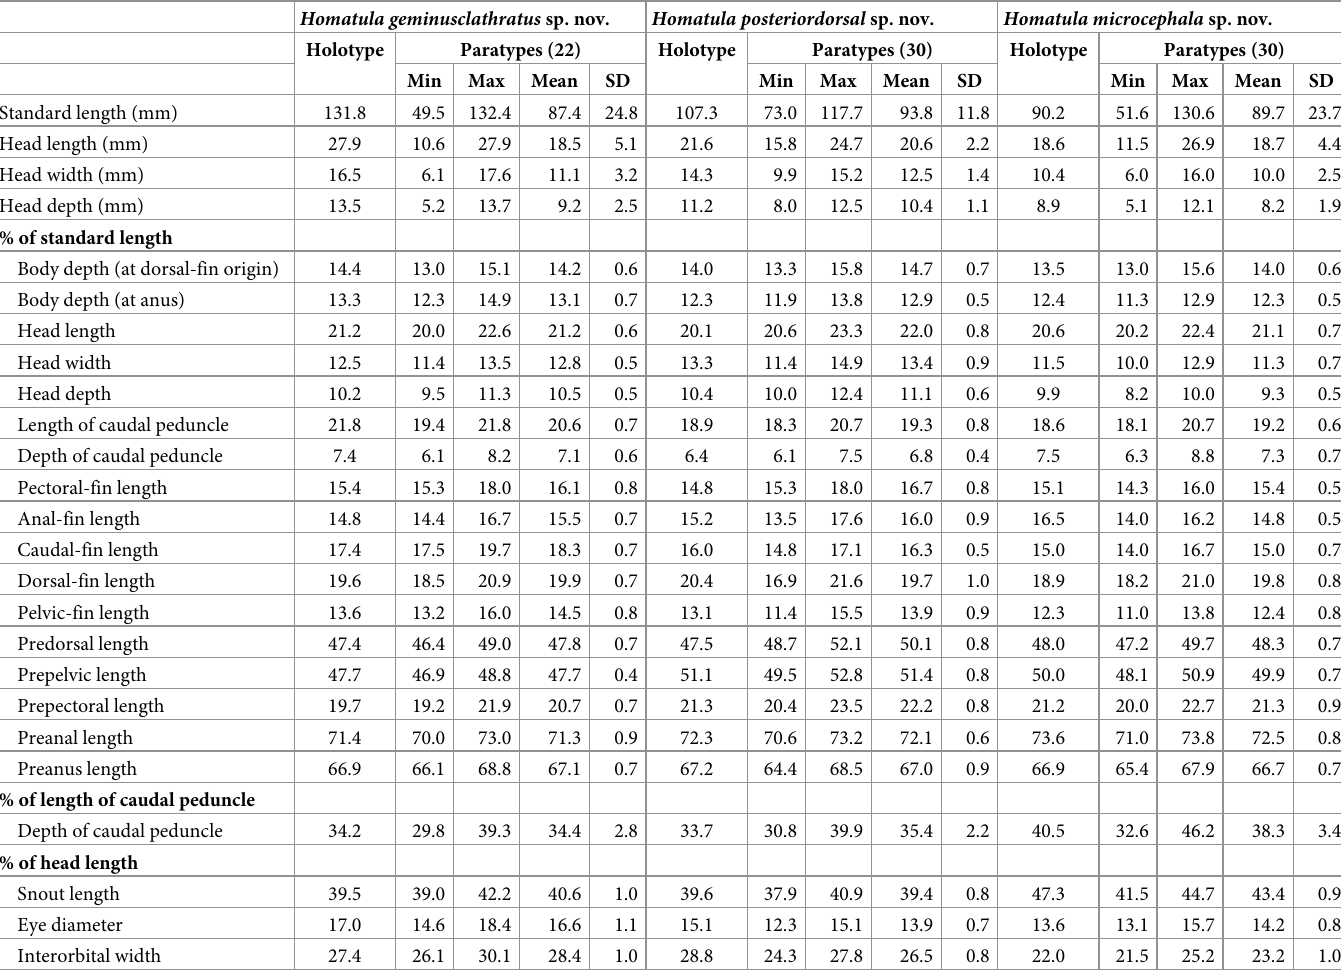
Table 3. Morphometric data for three new species of Homatula from the Lancang-jiang, Yunnan Province, China. Homatula geminusclathratus sp.